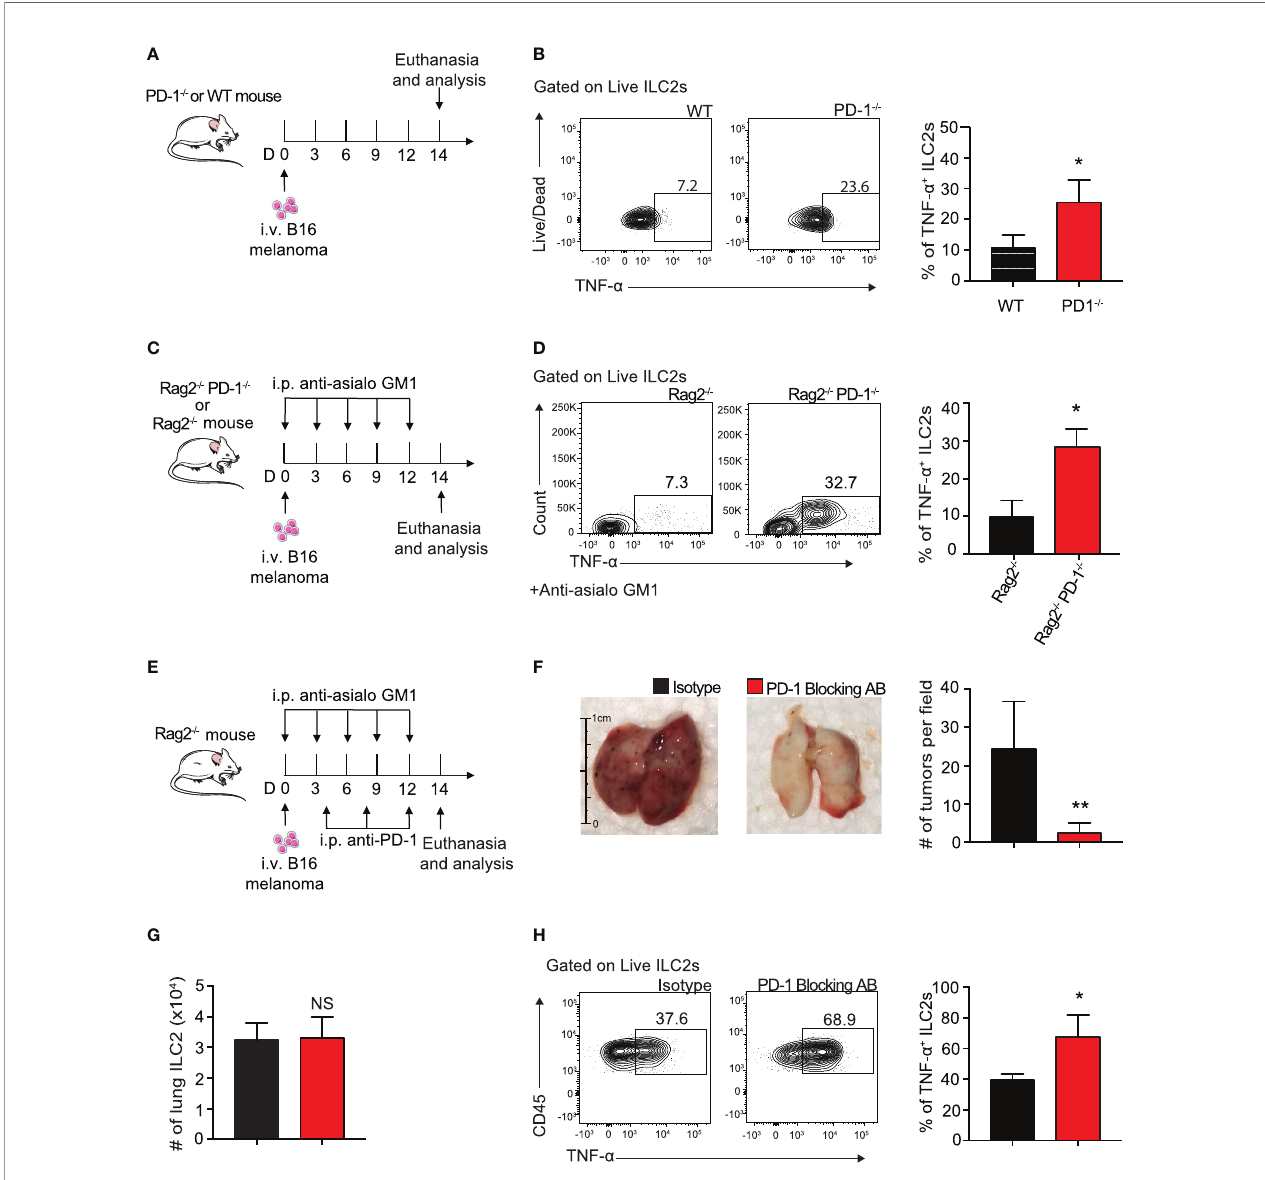
FIGURE 5 | Blocking ILC2 PD-1 expression increases TNF- a production and inhibits tumor progression in vivo . (A) A cohort of PD-1 -/- or WT mice was given an intravenous injection of B16 melanoma cells (2.5 x 10 5 ) on day 0. On day 14 lungs were digested and percentage of TNF- a + ILC2s was quanti fi ed (B) . (C) A cohort of Rag2 -/- or Rag2 -/- PD-1 -/- mice were intravenously injected with B16 melanoma (2.5 x 10 5 ) cells on day 0. Mice were also intraperitoneally injected with anti-asialo GM1 or isotype every three days. On day 14, mice were euthanized and percentage of TNF- a + ILC2s was quanti fi ed (D) . (E) A cohort of Rag2 -/- mice were intravenously injected with B16 melanoma cells (2.5 x 10 5 ) on day 0. Mice were intraperitoneally injected with anti-asialo GM1 or isotype every three days. Mice were also intraperitoneally injected with PD-1 blocking antibody or isotype (500µg/mouse) every four days. On day 14, mice were euthanized and lung tumor burden per fi eld was assessed and quanti fi ed (F) . (G) Total number of lung ILC2 cells present on day 14. (H) Representative fl ow cytometry plots and corresponding quanti fi cation of TNF- a + ILC2s present in the lung on day 14. Error bars are the mean±SEM. Data are representative of 3 individual experiments with n=5. Student ’